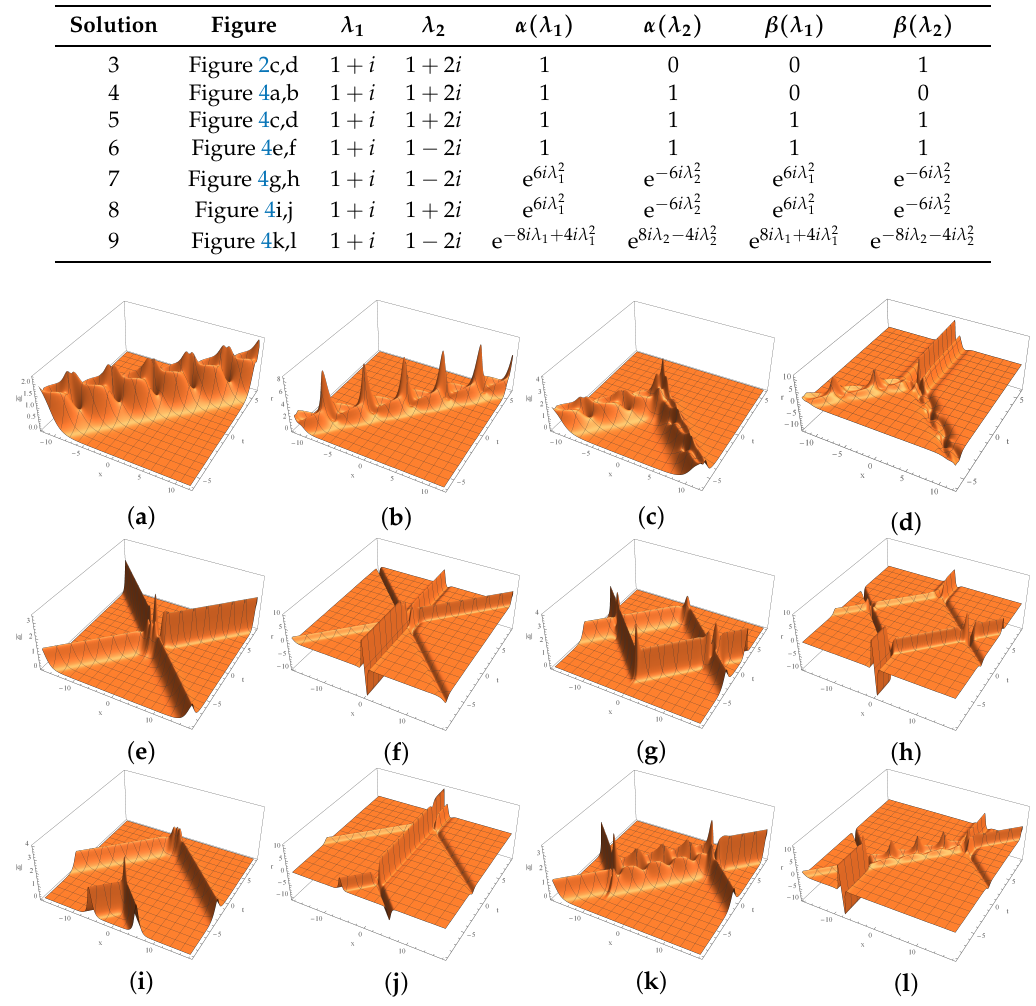
Figure 3. Density plot of ( c , d ) in Figure 2, with the auxiliary lines x = ± 2 t . Table 1. Examples of exact solutions for (10) by two-fold Darboux transformations.